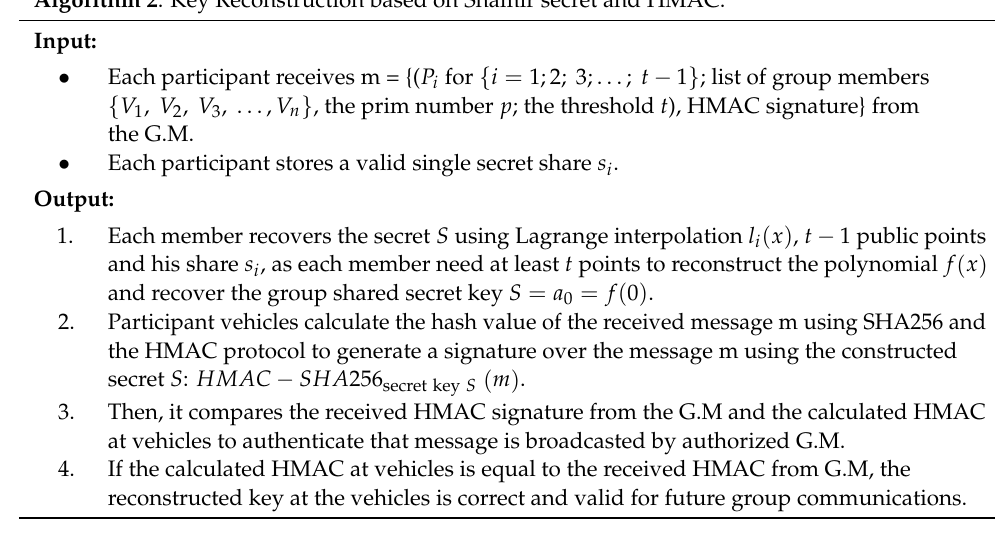
Algorithm 2 . Key Reconstruction based on Shamir secret and